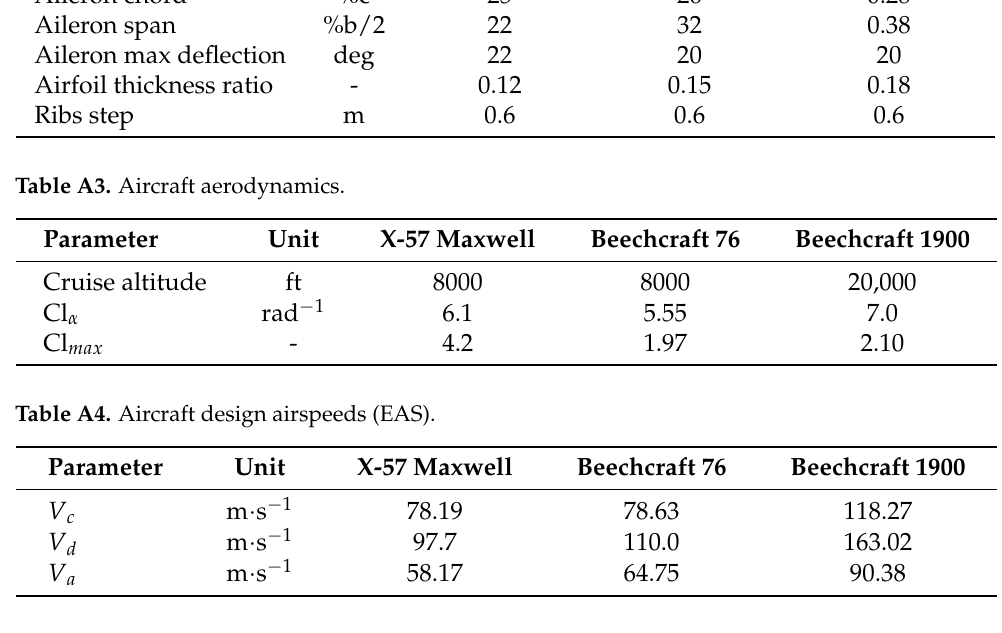
Table A5. Propulsion.